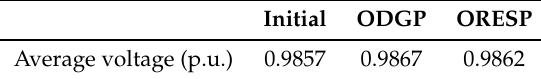
Figure 5. Voltage profile for 33 bus system regarding the ODGP and ORESP problems. Table 6. Average voltage profile for the 118 bus